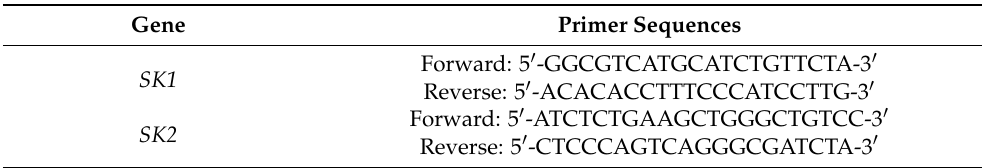
Table 1. Primer sequences of SK1 and SK2 genes used in qRT-PCR.